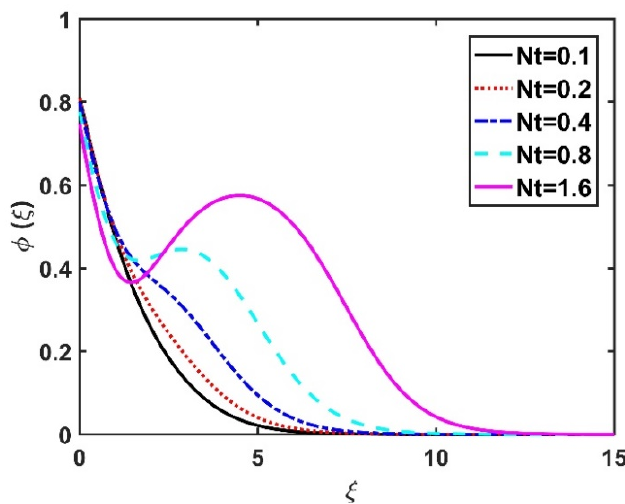
Figure 19. Impact of Nt on φ ( ξ )